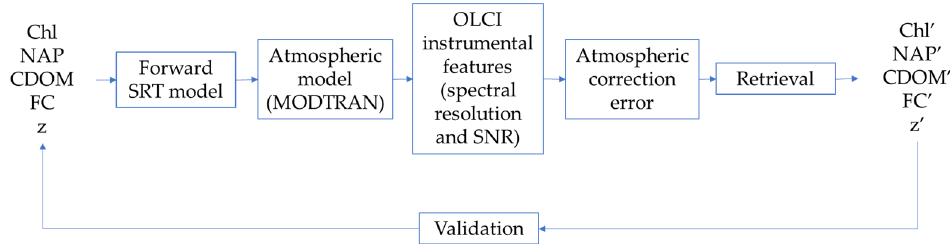
Figure 4. Flowchart describing the procedure used to determine the performances of SRT inversion retrievals.